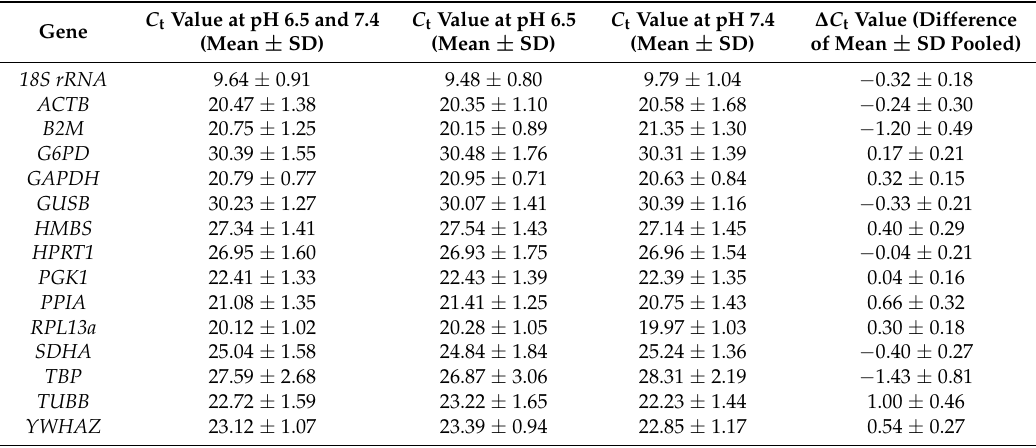
Table 2. Raw C t values of the candidate HKG in acid and physiological conditions (pH 6.5 and 7.4, respectively).